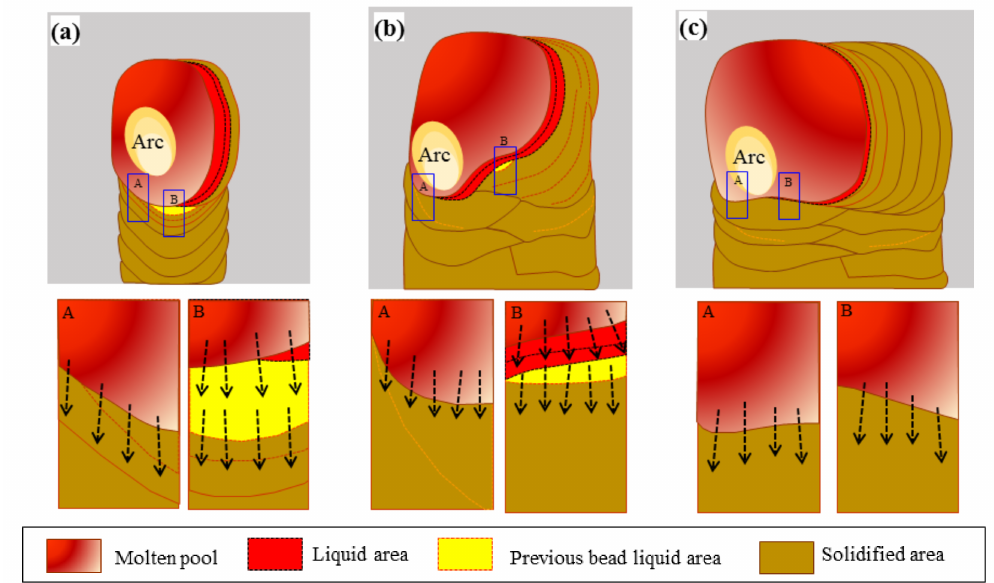
Figure 13. Schematic diagram of bead creation with respect to the heat input and heat flow; ( a ) low heat input; ( b ) medium heat input; and ( c ) high heat